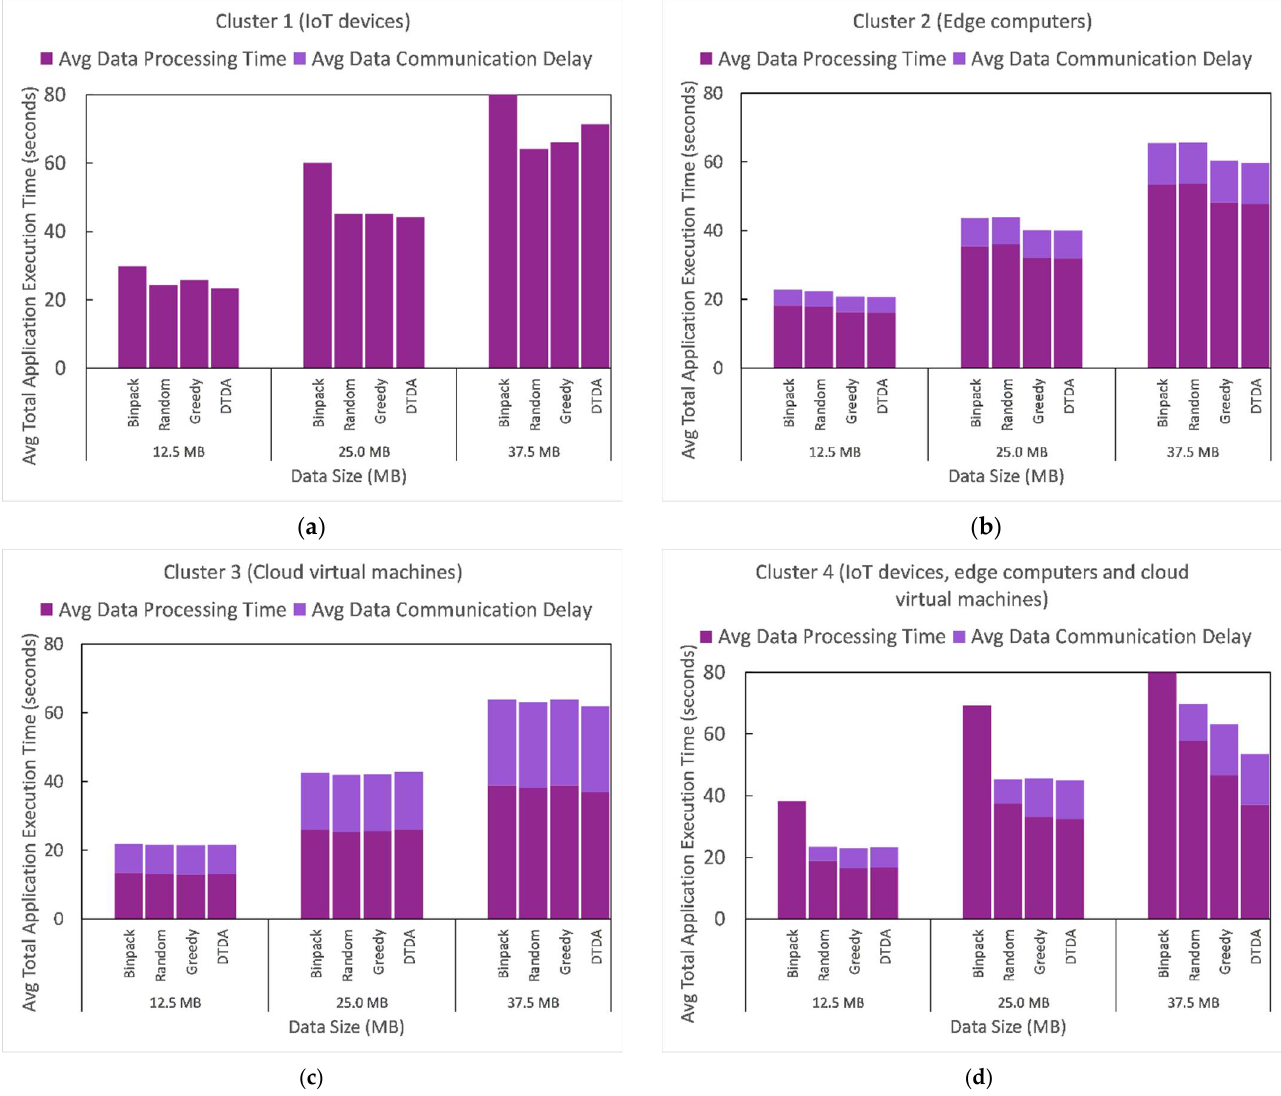
Figure 8. Comparison of the average data processing time, communication delay, and total application execution time of the passenger counting IoT application under each task management technique when executed in four different computing resources clusters with varying data sizes. ( a ) Cluster 1 (IoT devices). ( b ) Cluster 2 (edge computers). ( c ) Cluster 3 (cloud virtual machines). ( d ) Cluster 4 (IoT devices, edge computer and cloud virtual machine)